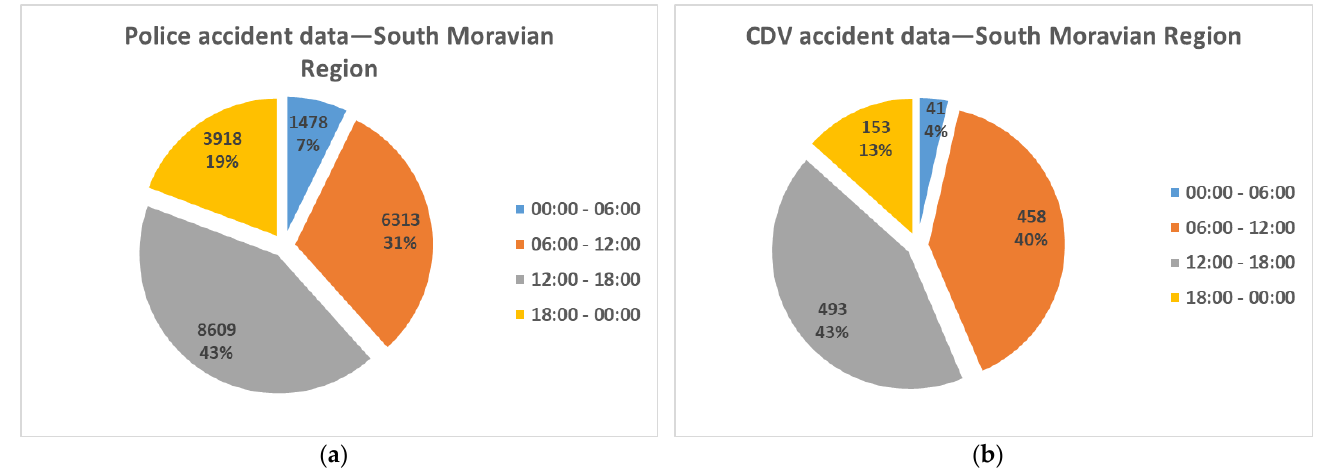
Figure 3. Comparison of police ( a ) and CDV data ( b ) on the time of day when accidents took place in the South Moravian Region